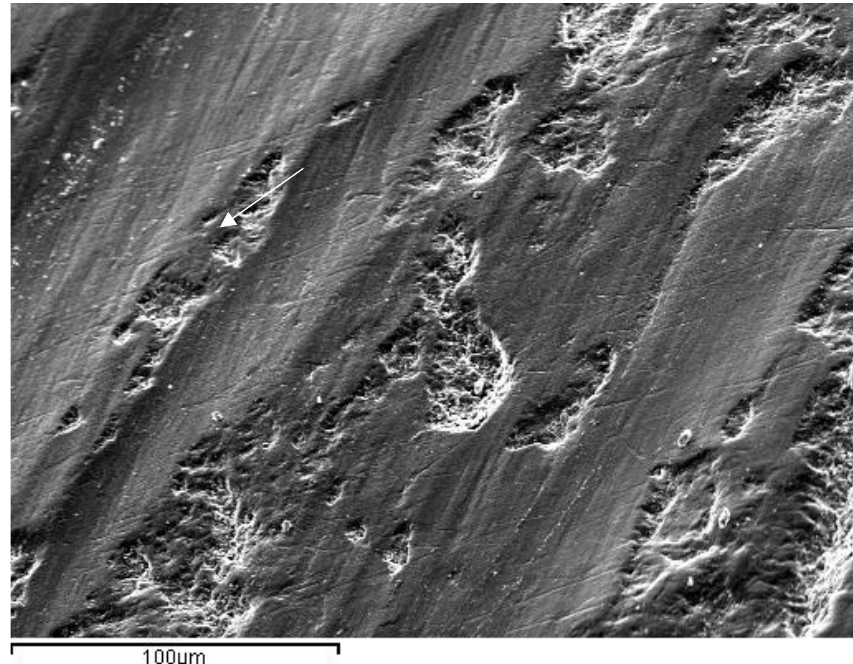
Figure 7. Representative image of enamel of a Group 1 sample after polishing with a white stone bur at a high speed (arrow points at the most evident indentation of the bur on the enamel surface).